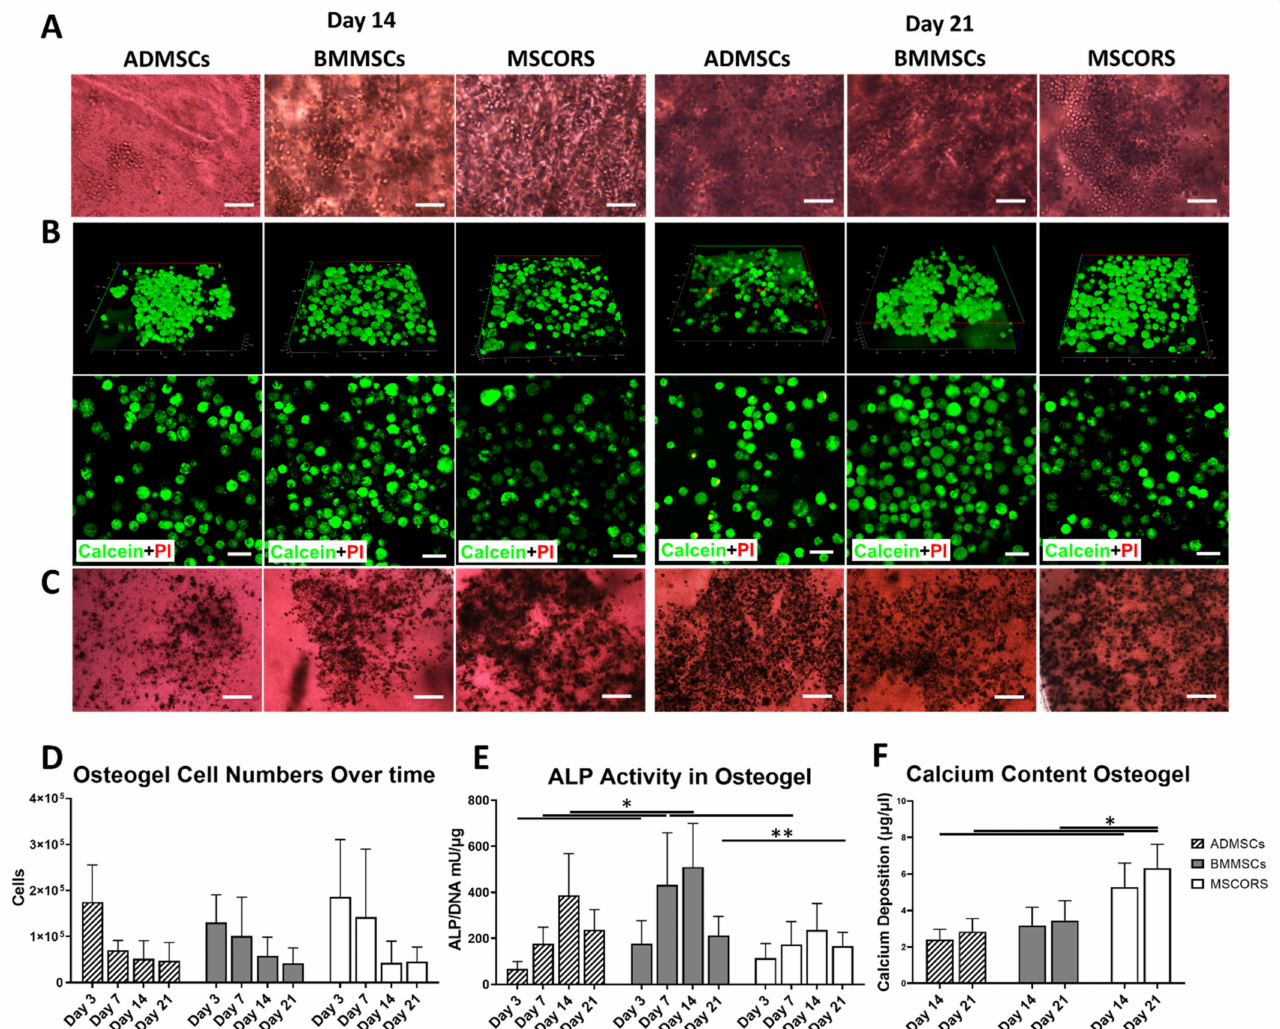
Figure 3. Osteogenic differentiation of ADMSCs, BMMSCs, and MSCORS in 3D in Osteogel. ( A ) Microphotographs of ADMSCs, BMMSCs, and MSCORS cultured in Osteogel under osteogenic differentiation conditions at day 14 and day 21. ( B ) Live/Dead assay of ADMSCs, BMMSCs, and MSCORS within the Osteogel, using Calcein AM (live/green) and Propidium Iodine (PI, dead/red), after osteogenic differentiation. ( C ) Alkaline Phosphatase (ALP) Visualization Assay based on 5-bromo-4-chloro-3-indolyl phosphate/p-nitroblue tetrazolium chloride (BCIP/NBT) chromogenic reaction in ADMSCs, BMMSCs, and MSCORS after Osteogel-based 3D osteogenic differentiation. ( D ) Cell numbers over the differentiation period quantified by DNA Picogreen assay at day 3, 7, 14, and 21. ( E ) Quantitative analysis of ALP activity vs. DNA content. ALP activity in MSCs was assessed using pNPP chromogenic assay over day 3, 7, 14, and 21 of differentiation. ( F ) Calcium deposition in ADMSCs, BMMSCs, and MSCORS quantified by the CPC Assay. Data are shown as mean ± SD (* p < 0.05). Comparison of each group was statistically analyzed by unpaired Student’s t-test or nonparametric Mann–Whitney test. Statistical significance: * p < 0.05, ** p < 0.01. Scale bar and magnification: ( A ) 100 µ m, 20 × ; ( C ) 200 µ m, 10 × ; ( B ) 50 µ m, 63 ×